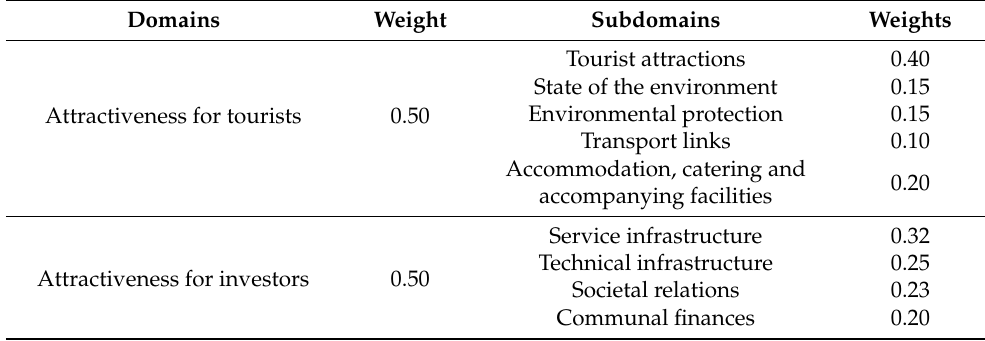
Table 1. Domains and subdomains within which diagnostic features and weights were selected (applying the approach of Gołembski [15]).